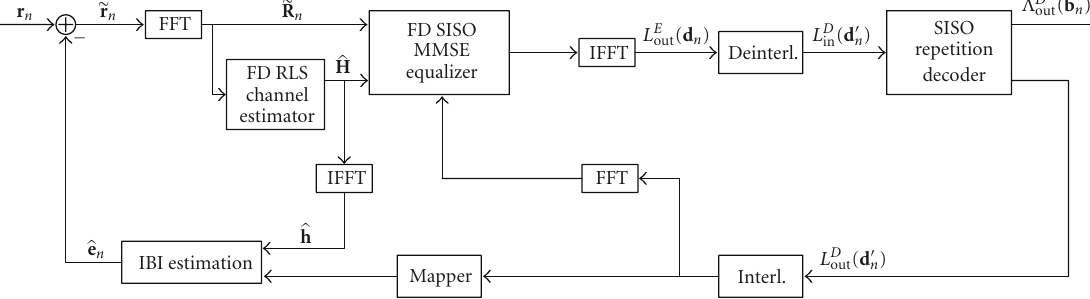
Figure 1: Block diagram of the proposed